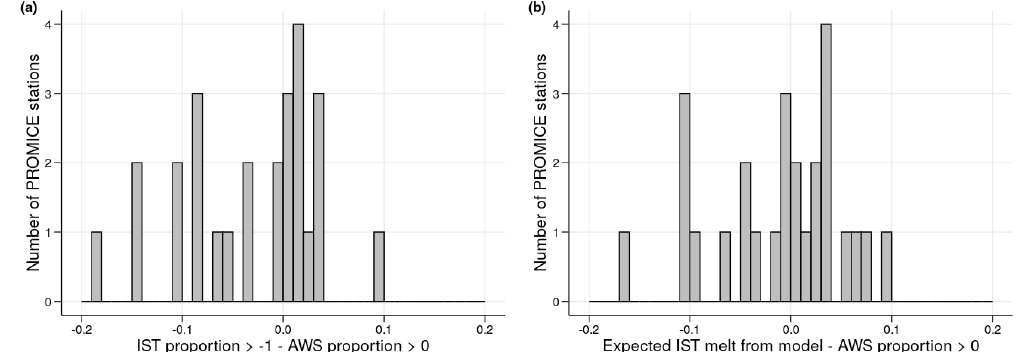
Figure 6. A comparison of the empirical melt from Programme for Monitoring of the Greenland Ice Sheet (PROMICE) AWS data (proportion of data ≥ 0 ◦ C) with empirical MODIS IST estimates (proportion of data ≥ 0 ◦ C) and mixture-model-based expected melt estimates. Only dates with data available from both datasets are used, meaning the above estimates are valid only for cloud-free days due to the limitations of the MODIS IST dataset.